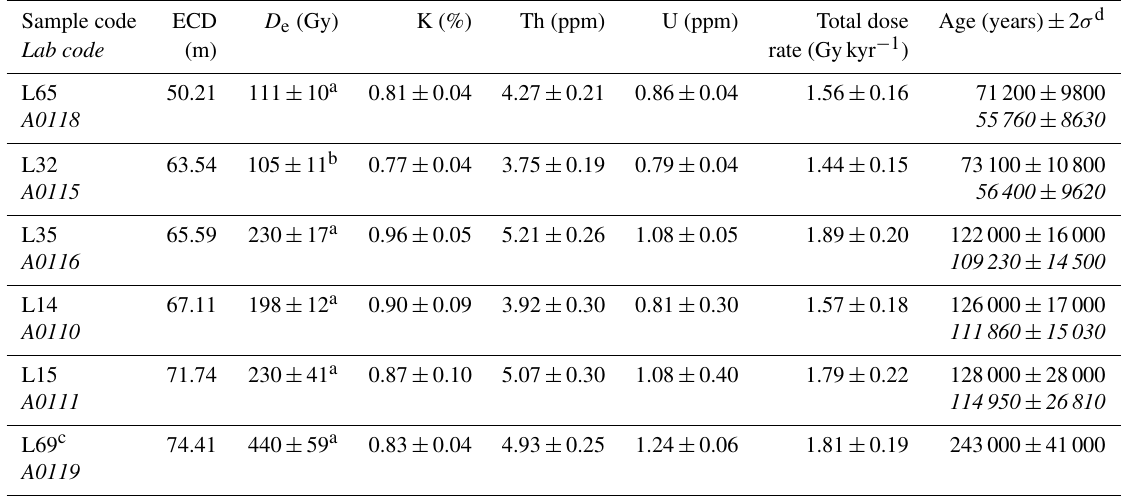
Table 4. Equivalent dose ( D e ), total dose rate data, and pIR-IRSL 290 age estimates for the Orakei 4–11µm polymineral fine-grained samples. Sample code